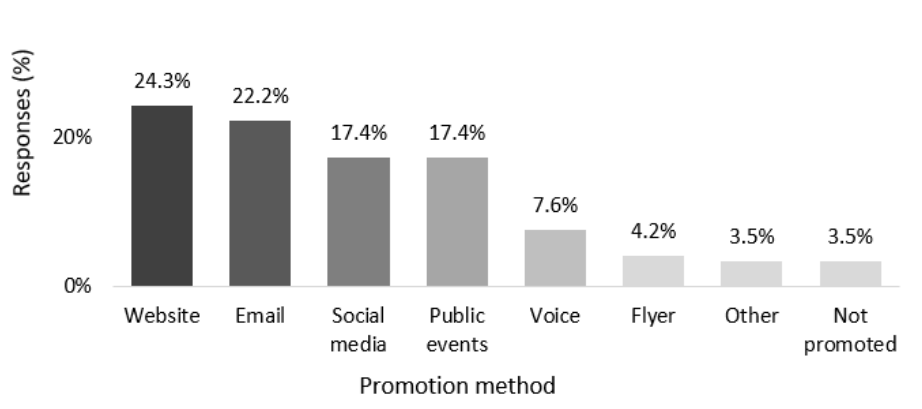
Figure 11. Methods used by respondents to promote the initiative.